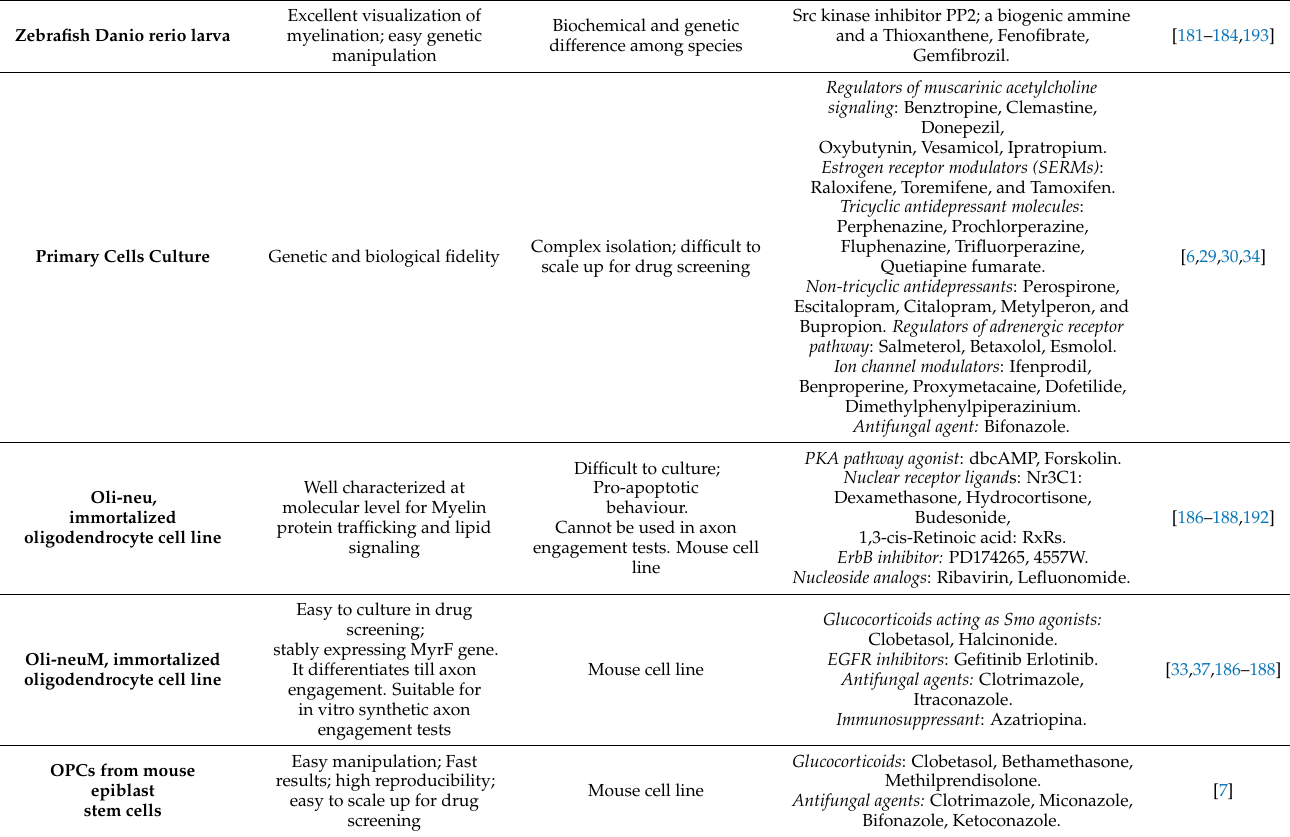
Table 2. Models for drug screening: advantages and disadvantages and selected drugs. Model for Drugs